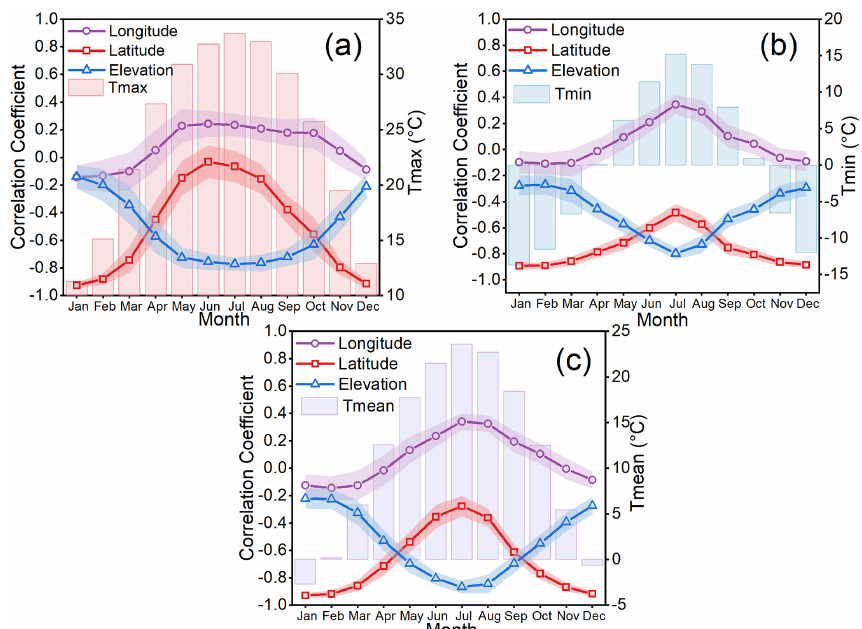
Figure 2. Correlation coefficients between (a) monthly maximum air temperature (Tmax), (b) minimum air temperature (Tmin), and (c) mean air temperature (Tmean) and longitude, latitude, and elevation for each month. Coloured shading indicates the standard devia- tion. Note that the correlation coefficients are the average values of the correlation coefficients for each month over 70 years